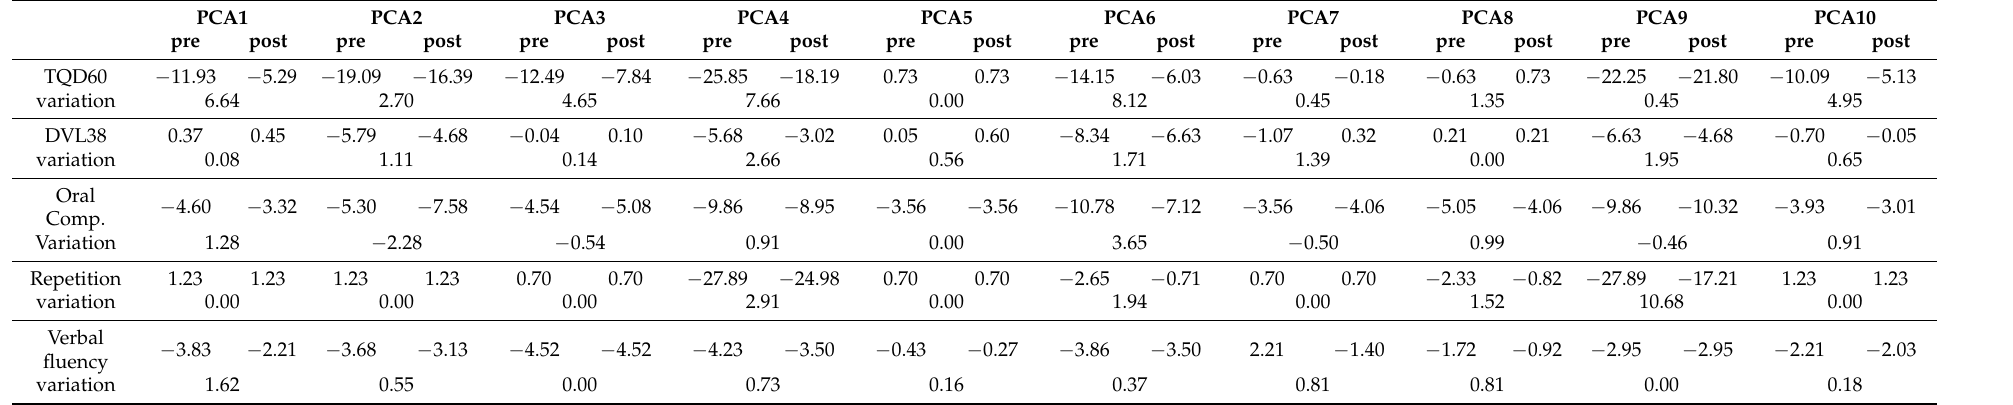
Table A1. Standardized language test scores at T0 and T1 for all